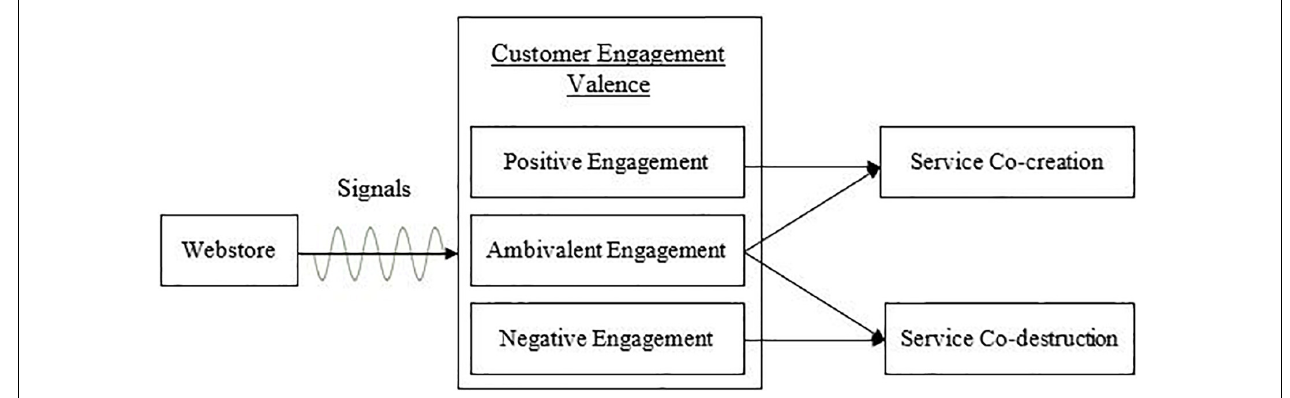
FIGURE 1 | Engagement valence outcomes